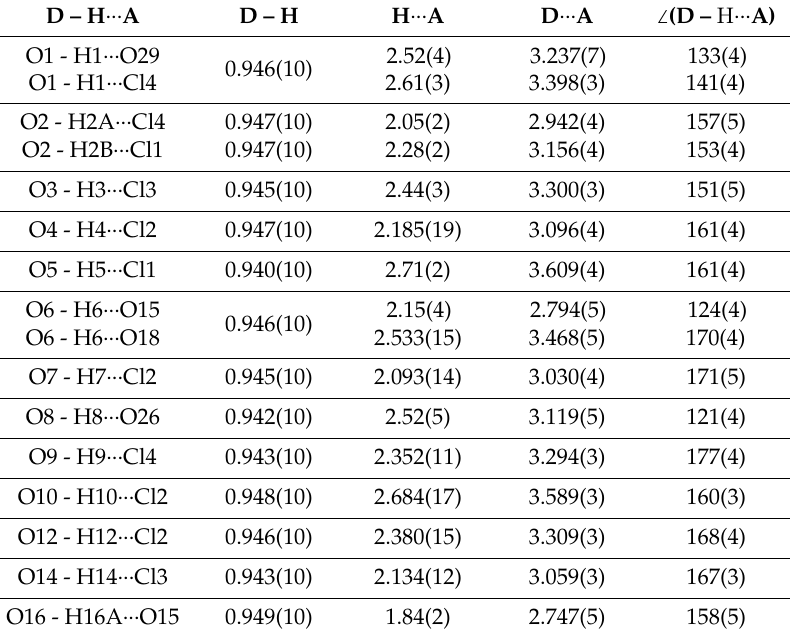
Table 5. Hydrogen-bond geometry (Å, ◦ ) in the structure of